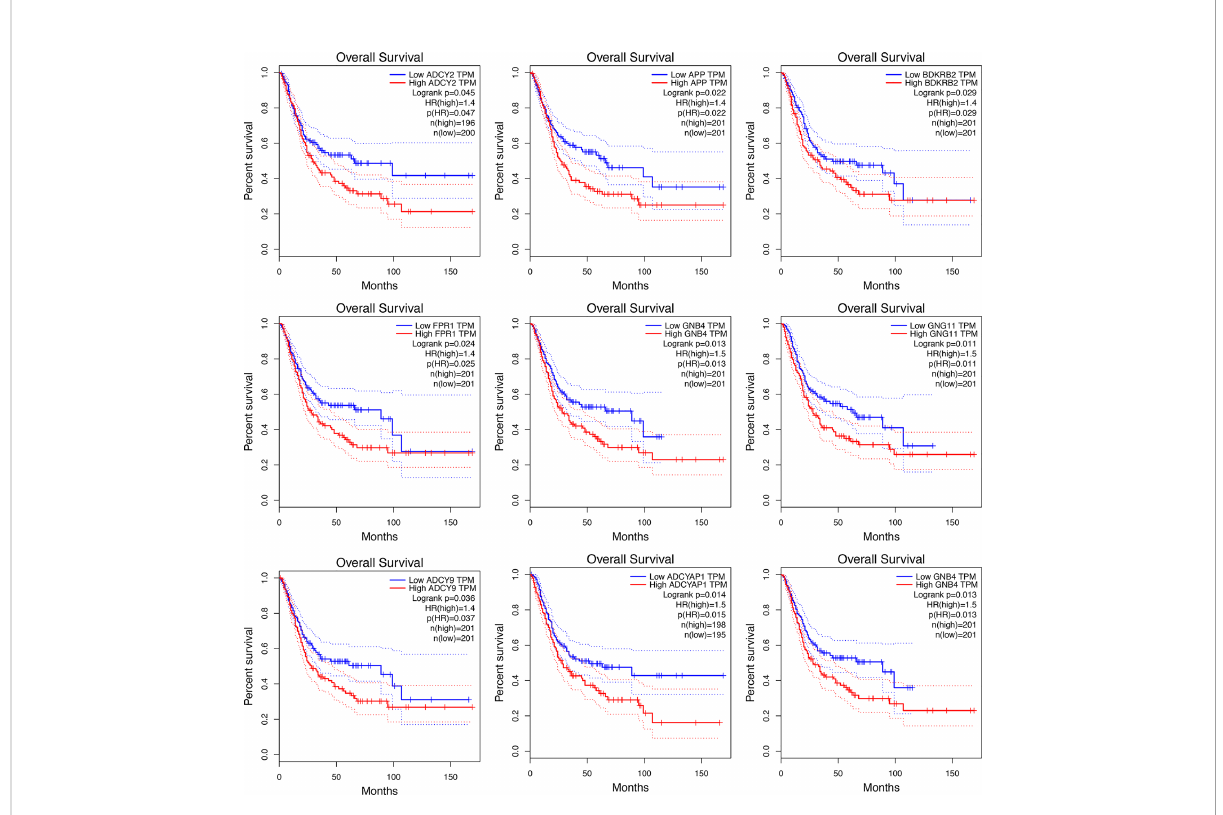
FIGURE 3 The KM curve indicates the overall survival of the selected differential